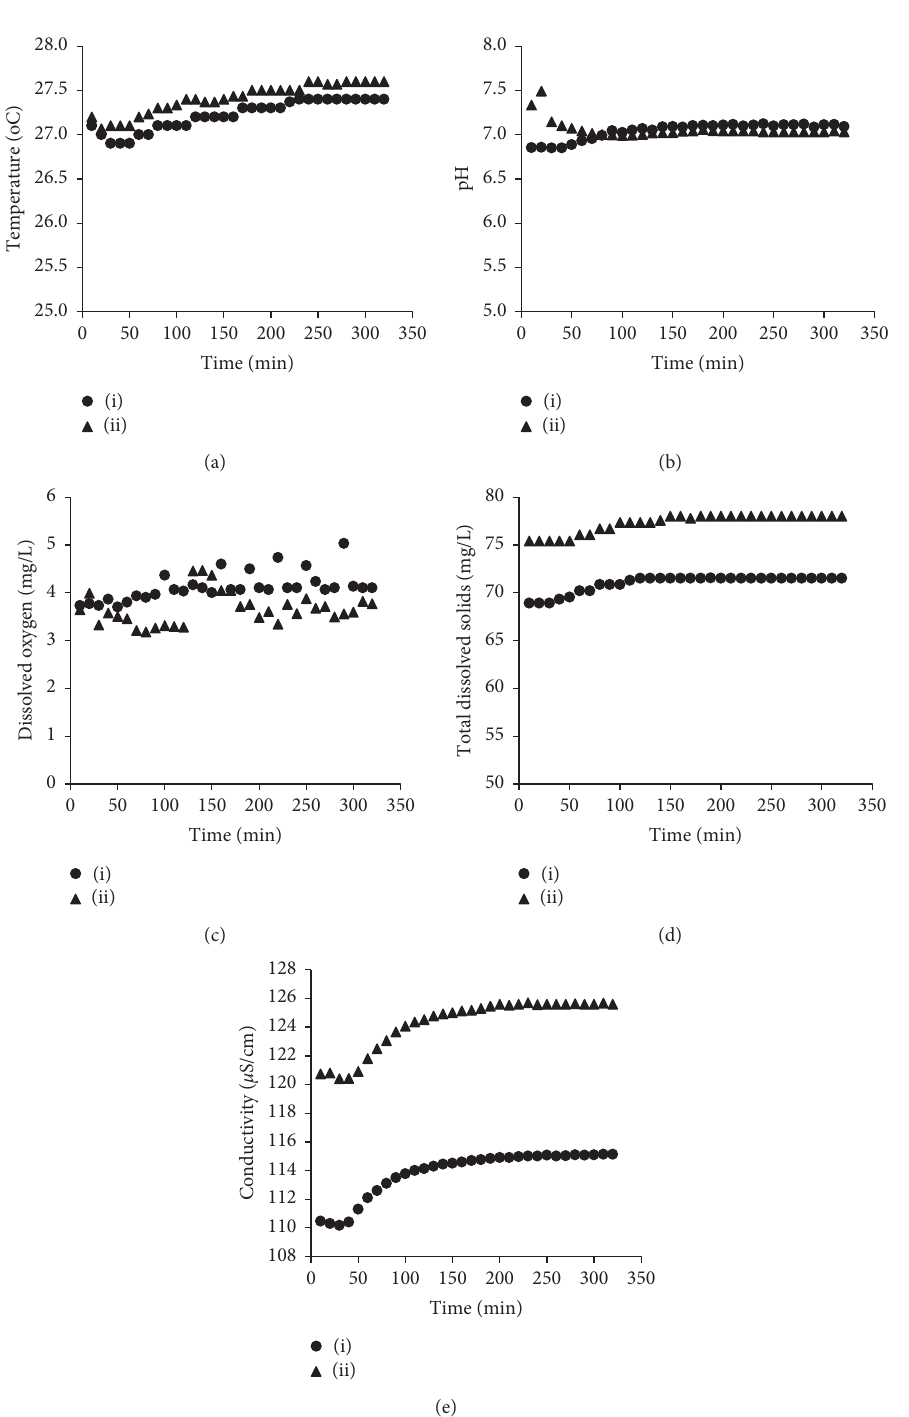
Figure 2: Variation of (a) temperature, (b) pH, (c) dissolved oxygen, (d) total dissolved solids, and (e) conductivity monitored at the (i) influent and (ii) effluent of the simulated